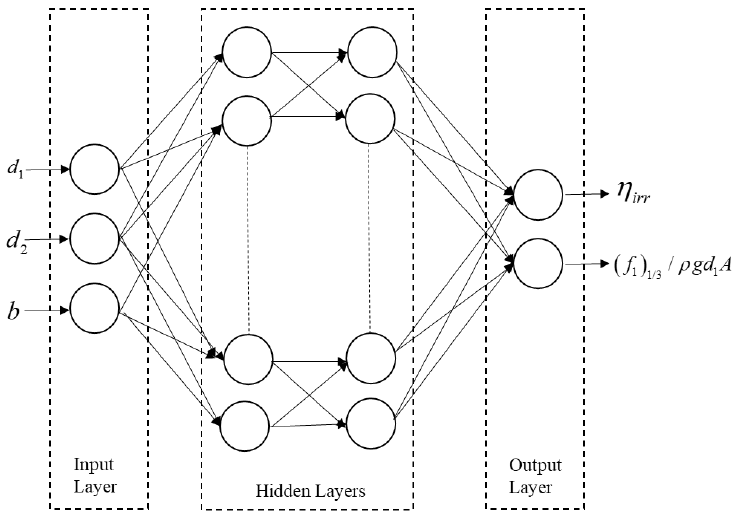
Figure 13. Architecture of an ANN Model.